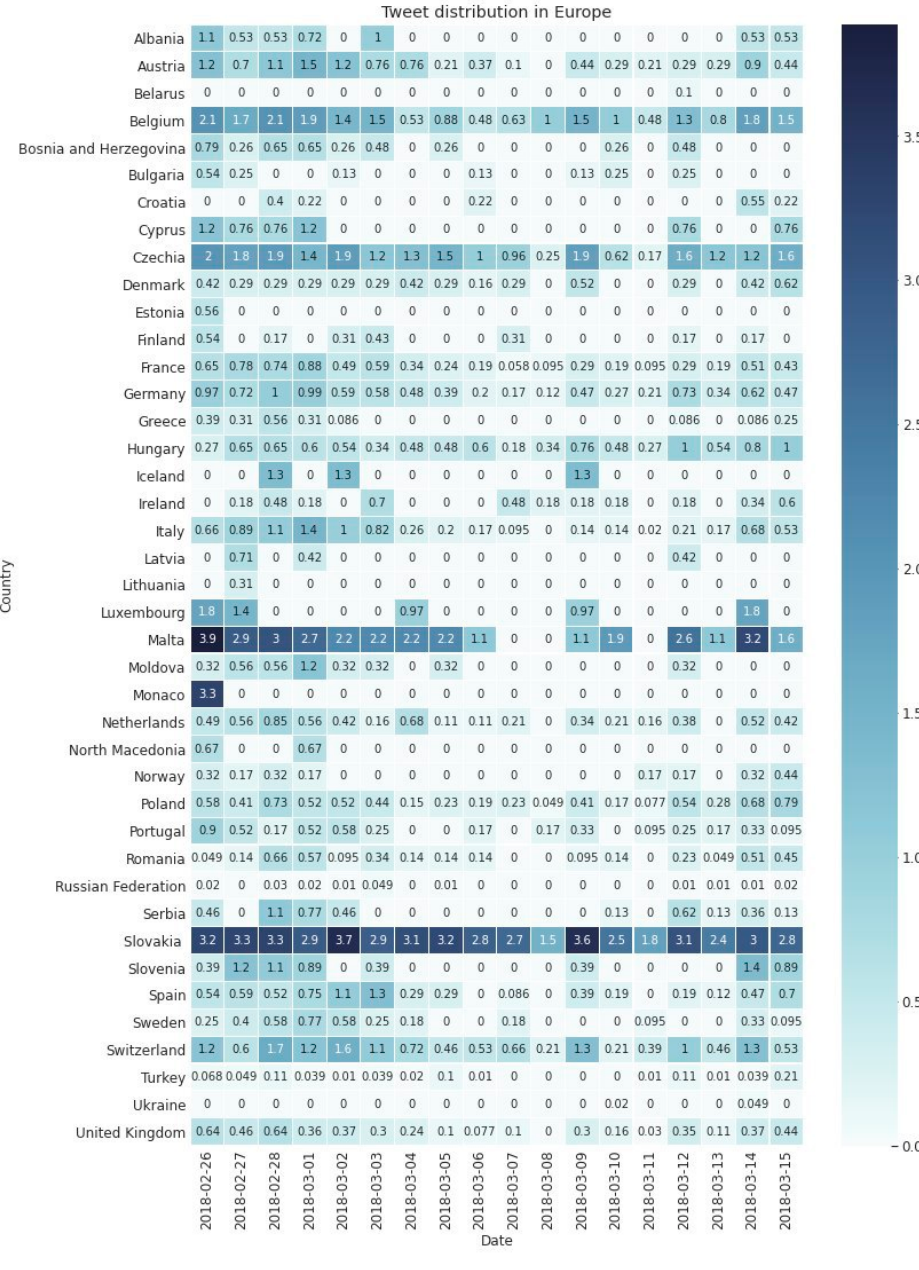
Figure 5. Number of tweets (normalized) per country per day (RQ1a).